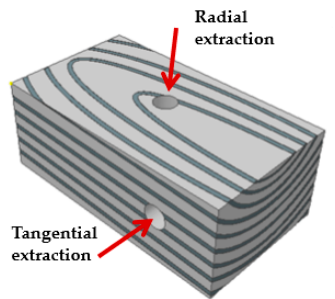
Figure 2. Specimen and sampling locations. Figure 2. S pecimen and sampling locations.